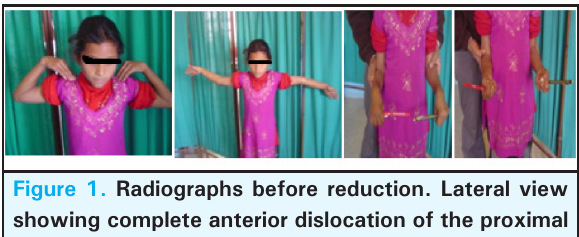
Figure 1. Radiographs before reduction. Lateral view showing complete anterior dislocation of the proximal radius and ulna. There is no associated fracture.